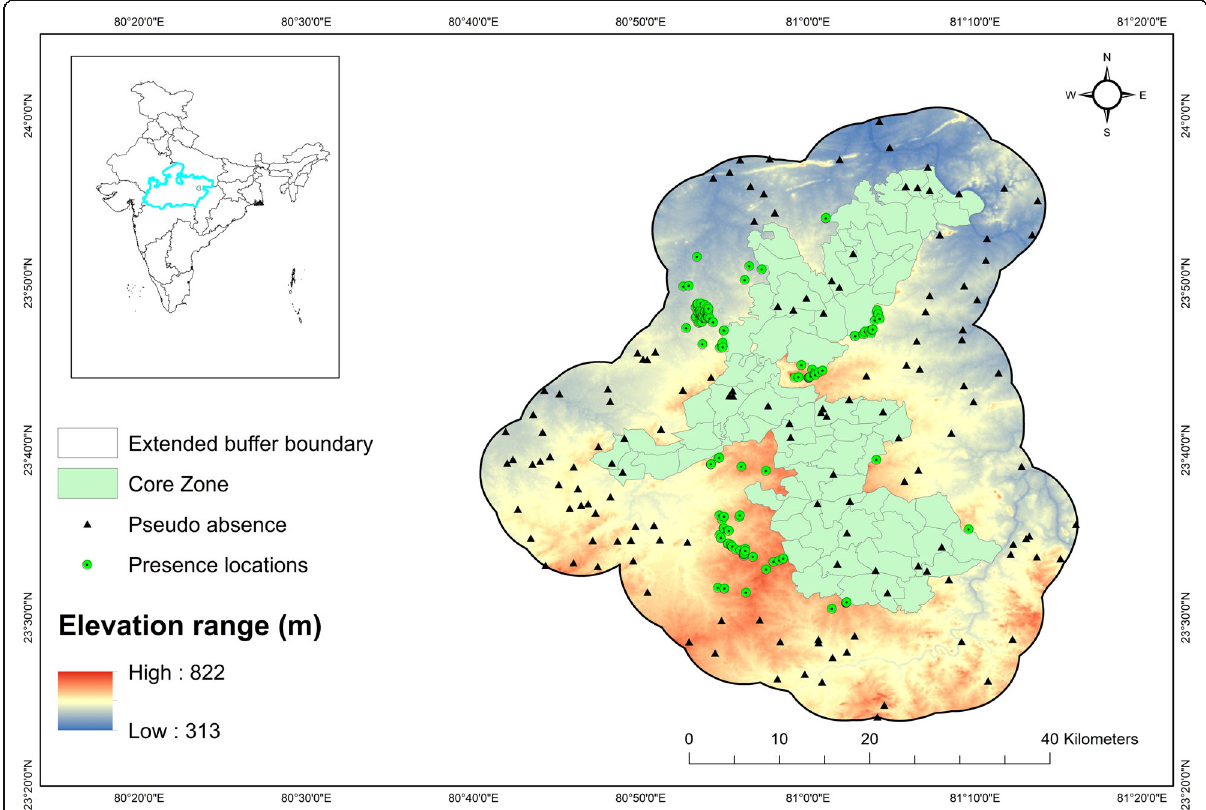
Fig. 1 Location of the Bandhavgarh Tiger Reserve, Madhya Pradesh, India. Green dots represent the scat locations; solid black dots represent the camera trap captures of sloth bears, and black triangular marks represent the pseudo-absence records generated in ArcGIS